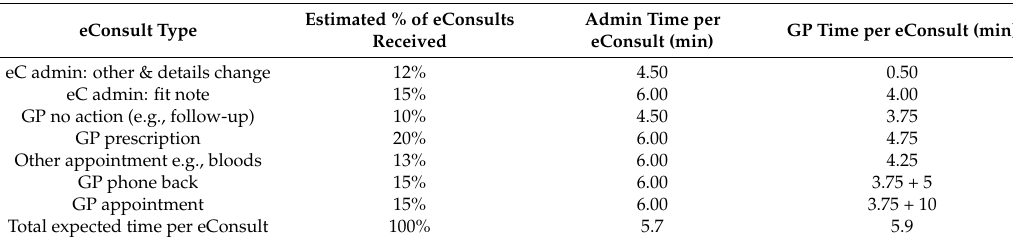
Table 3. Timings for different types of